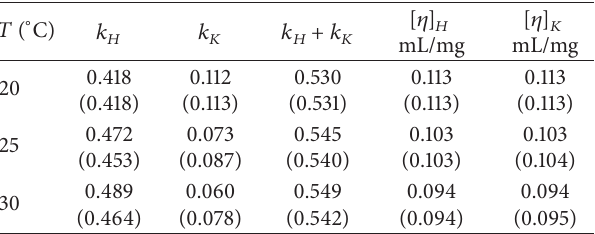
Table 1: Intrinsic viscosities and Huggins and Kraemer constants of PEOX